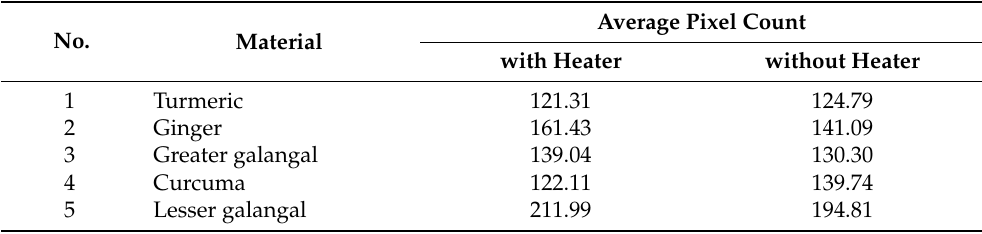
Figure 9. Intensity of the RGB level of each dried rhizome with and without heater employment analyzed using ImageJ software: ( a ) turmeric, ( b ) ginger, ( c ) greater galangal, ( d ) Curcuma, ( e ) lesser galangal [32]. Table 5. Summary of the average pixel counts of the RGB level of each dried rhizome with and without heater employment analyzed using ImageJ software [32].